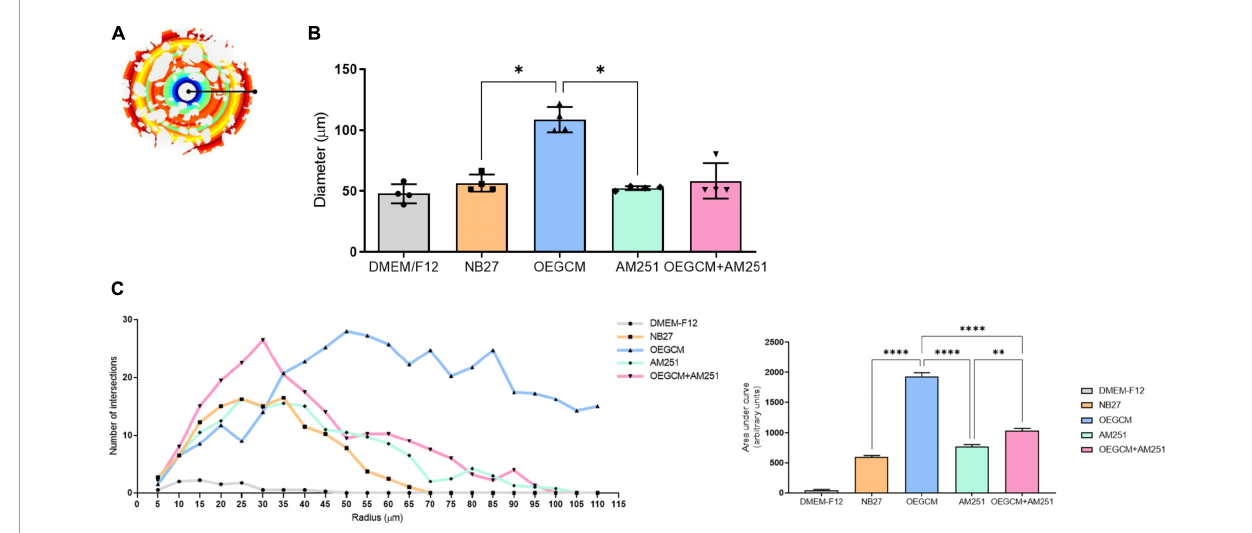
FIGURE5 Sholl analysis from O4 data imply a role for CB1 on OEGCM ability to increase the complexity of oligodendrocytes process branching. In panel (A) , the Sholl circles from one O4-positive oligodendrocyte from OEGCM condition. In panel (B) , the diameter from O4-positive oligodendrocytes in the different conditions. Data is presented as mean ± SD, statistical analysis was performed using One-way ANOVA and Holm-Sídák’s as post hoc test. N = 4 for all experimental conditions, p = 0.0165 for NB27 vs. OEGCM, p = 0.8079 for NB27 vs. AM251, p = 0.0951 for OEGCM vs. OEGCM + AM251, p = 0.9585 for AM251 vs. OEGCM + AM251, p = 0.0121 for OEGCM vs. AM251. In panel (C) , the area under the curve calculates the number of intersections in every 0.5 µ m radium in each Sholl circle. Data is presented as mean ± SD, statistical analysis of AUC was performed using One-way ANOVA and Sídák’s as post hoc test. N = 4 for all experimental conditions, p < 0.0001 for NB27 vs. OEGCM, p = 0.0586 for NB27 vs. AM251, p < 0.0001 for OEGCM vs. OEGCM + AM251, p = 0.0021 for AM251 vs. OEGCM + AM251, p < 0.0001 for OEGCM vs. AM251. * p < 0.05, ** p < 0.01, and **** p <